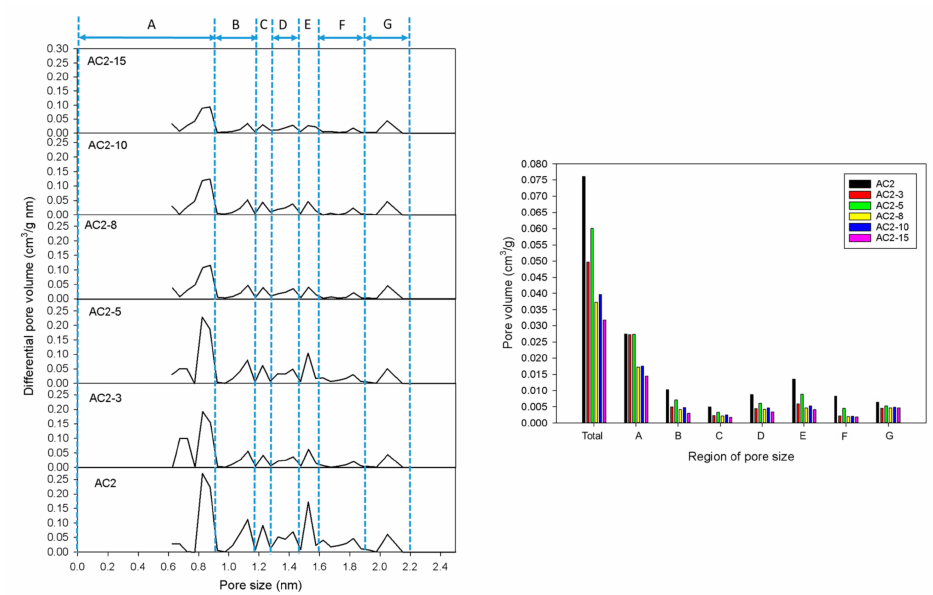
Figure 12. Pore size distributions of the original and NaOH impregnated AC2 derived from CO 2 adsorption isotherms at 273 K and computed by Monte Carlo optimization and mass balance